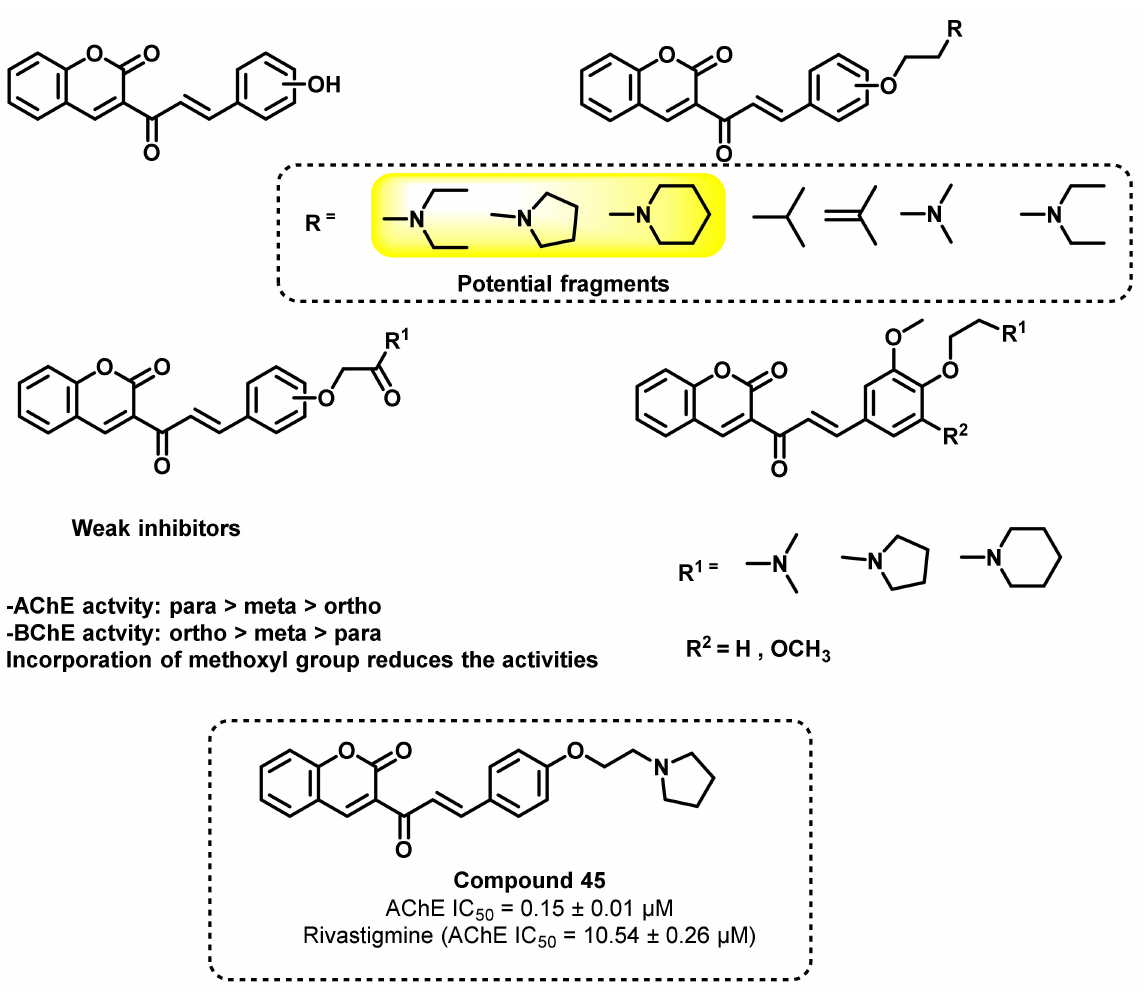
Figure 40. Chemical structures of coumarin–chalcone hybrid